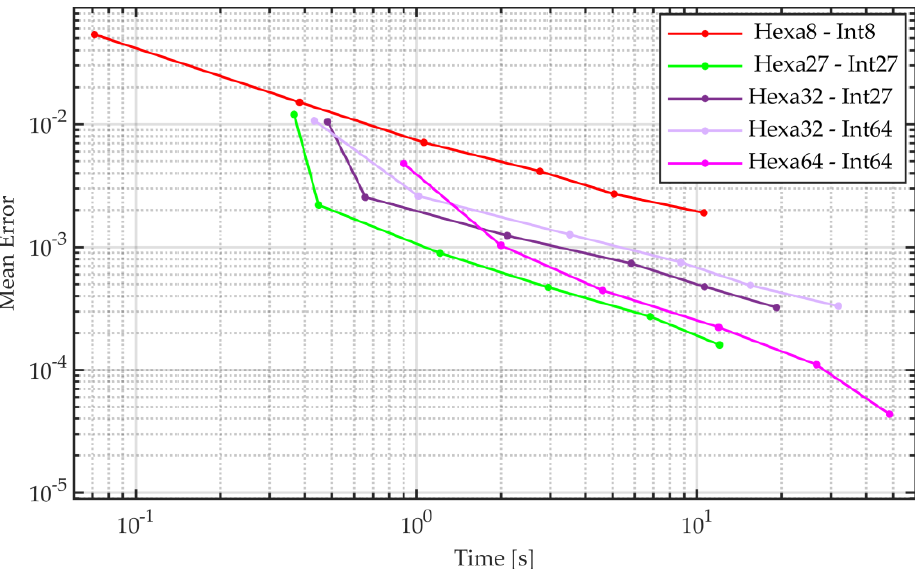
Figure 8. Convergence analysis of serendipity cubic FE formulations as a function of the assembly time in comparison with full − order elements.